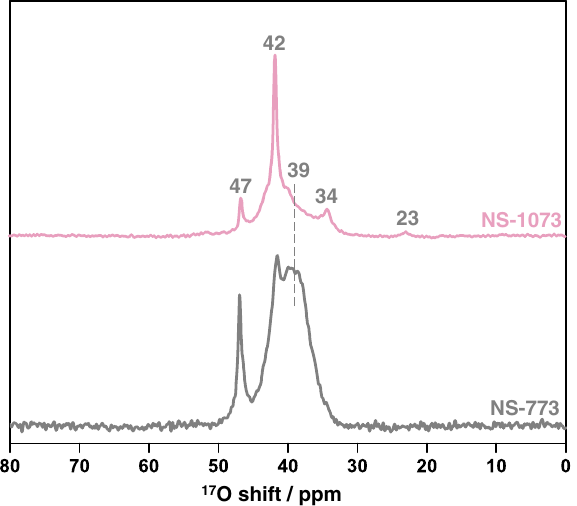
Fig. 1 17 O single-pulse MAS NMR spectra of MgO nanosheets. External fi eld: 19.6 T; MAS rate: 16 kHz; recycle delay: 5 s. The spectra are plotted such that the highest peak in each spectrum is at the same height and the relative intensities of different peaks can be conveniently